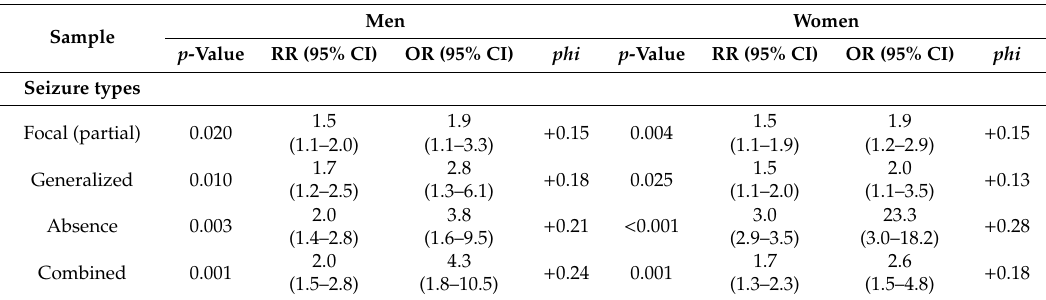
Figure 5. The frequency of hypomethylated (unmethylated) UPS29 alleles in patients with different clinical patterns of seizures: Type ( A ), frequency ( B ), duration ( C ), and the time of day of seizure onset ( D ). The data is shown with 95% CI. The asterisk indicates statistically significant differences in comparison with control (healthy subjects). Table 10. The association of UPS29 hypomethylation with a clinical pattern of seizures in patients with epilepsy.